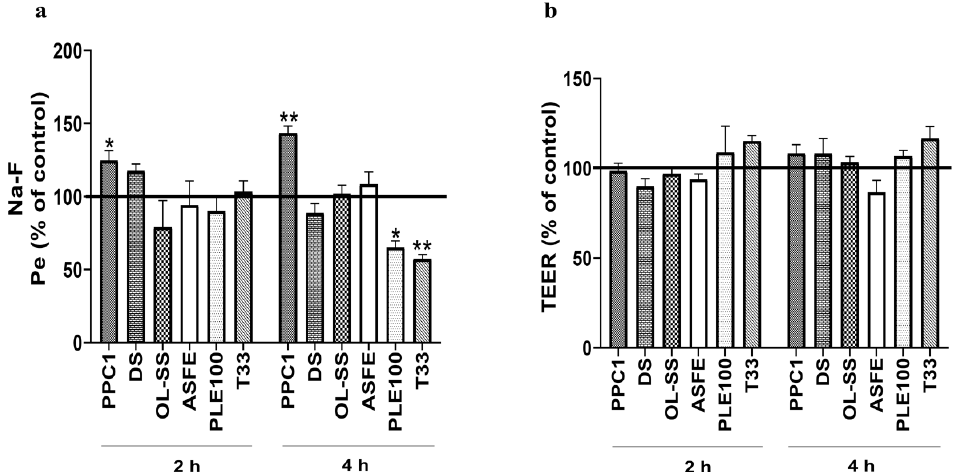
Figure 3. Effect of extracts in blood–brain barrier (BBB) integrity. Confluent HBMEC monolayers seeded onto semi-permeable membranes were treated with the indicated concentrations of each extract: Coffea arabica silverskin (PPC1; 50 µ g/mL), Dunaliella salina (DS; 10 µ g/mL), Olea europaea L. leaves (OL-SS; 40 µ g/mL), cooperage woods of Robinia pseudoacacia (ASFE; 24 µ g/mL), Citrus sinensis waste (PLE100; 15 µ g/mL) and Cyphomandra betacea peel (T33; 30 µ g/mL) diluted in RPMI, or RPMI only (control), for 2 and 4 h. Alterations in BBB properties were evaluated by endothelial paracellular permeability to sodium fluorescein (Na-F) ( a ) and trasendothelial electrical resistance (TEER) measurements ( b ). Quantitative analysis of both parameters revealed that PPC1 is the only extract that impairs the HBMEC endothelium, whereas PLE100 and T33 improve the BBB restricted permeability. Data are expressed as mean ± SEM of three independent experiments. Statistical analysis was performed by two-way ANOVA and the significance is shown as * p < 0.05, ** p < 0.01 vs.